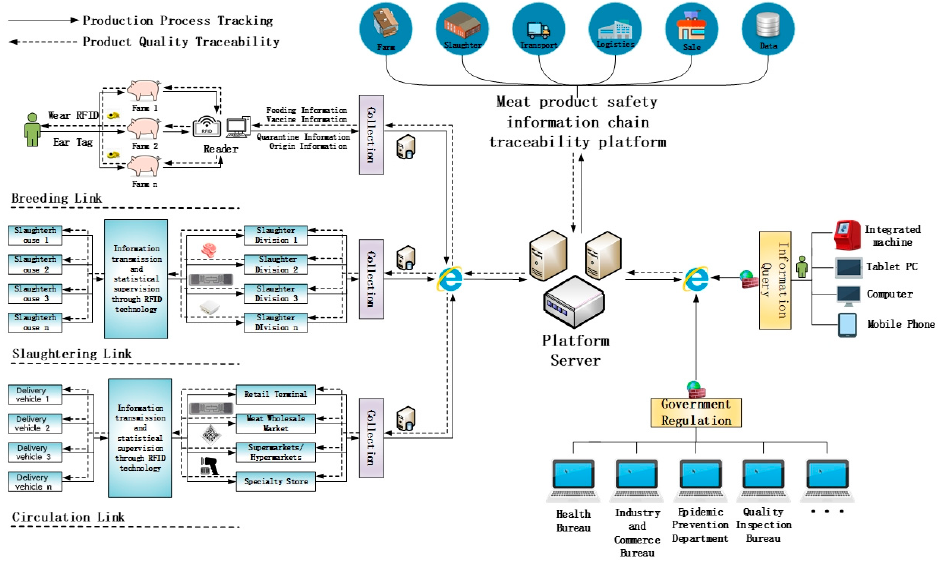
Figure 1. The business process of traceability system.